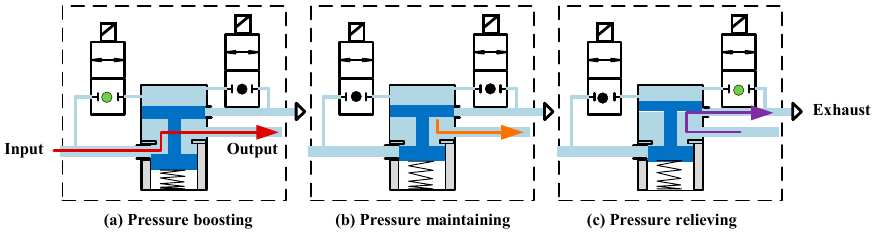
Figure 6. Schematic diagram of EBS pressurization, pressure maintaining and depressurization cycle.